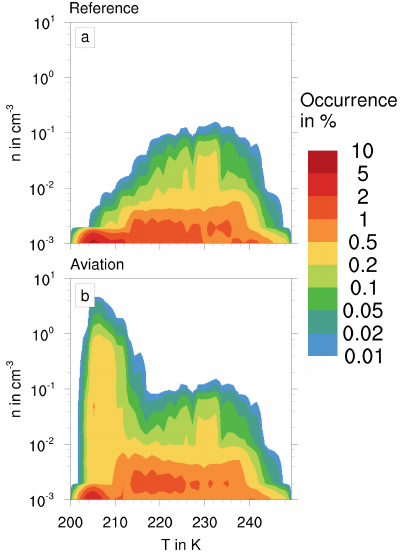
Figure 8. Relative occurrence of ice crystal number concentration versus temperature for natural cirrus, contrail, and contrail cirrus at 12:00UTC for the cross section along the black line in Fig. 4: (a) reference simulation; (b) aviation simulation.